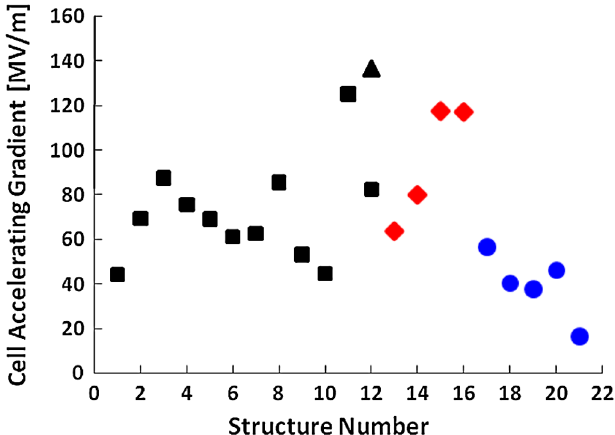
FIG. 3. (Color) First cell accelerating gradient for the structures from Table I scaled to the pulse length of 200 ns and BDR of 1 (cid:4) 10 (cid:5) 6 bpp = m ( h —X-band TWSs, e —X-band SWSs, d — 30 GHz TWSs, m —last cell accelerating gradient in structure number 12). Structure number is as in Table I.